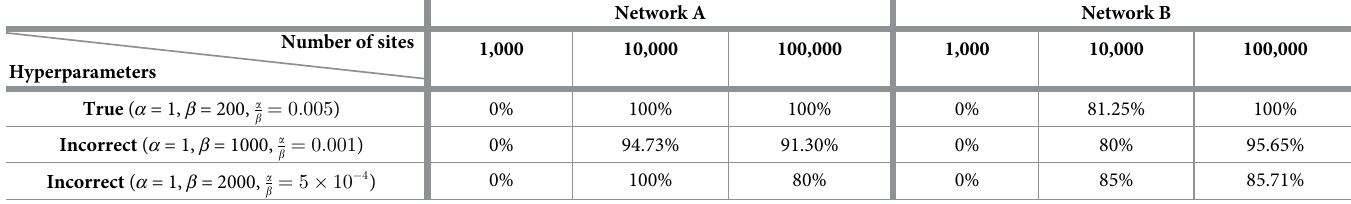
Table 1. Average posterior probability of the correct topology (for networks A and B, see Fig 7) obtained by running S NAPP N ET on simulated data. Results are given as a function of the number of sites and as a function of the hyperparameter values α and β for the prior on θ ( θ * Γ ( α , β ) and E y ð Þ ¼ a per species. Constant sites are included in the analysis, the rates u and v are considered as known, and 20 replicates are considered for each simulation set up (criterion ESS > 200; d � E ð 0 : 1 Þ , r * Beta(1, 1), t � E ð 10 Þ for the network 0